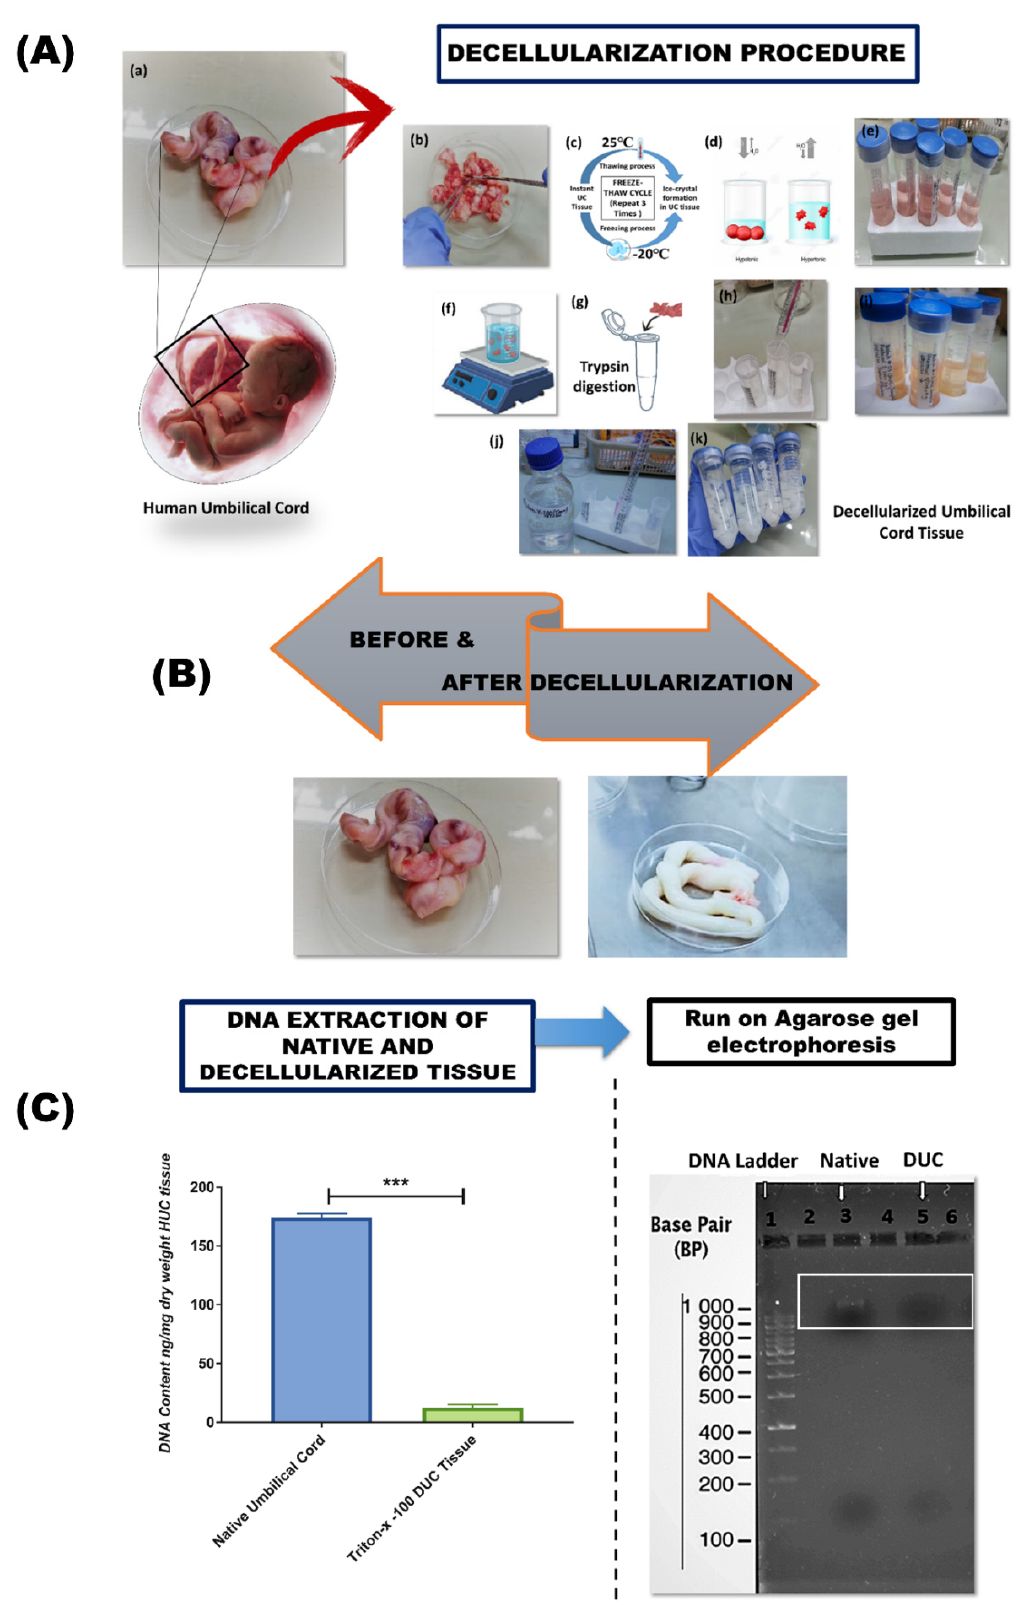
Figure 1. Diagrammatic representation of the procedure of decellularization of human umbilical cord tissue: ( A ) The human umbilical cord was collected ( a ), the cord sample was washed with de-ionized water to remove blood cells and minced in small pieces (about 6–7 cm) with a scalpel, and then washing was performed with water ( b ), tissue was frozen–thawed 3 times for 1 h each ( c ), the tissue was then subjected to osmotic shock using hypotonic and hypertonic solution ( d , e ), enzymatic digestion of tissue with 0.05% trypsin/EDTA for 2 h incubated at 37 °C ( f – i ), tissue sample was